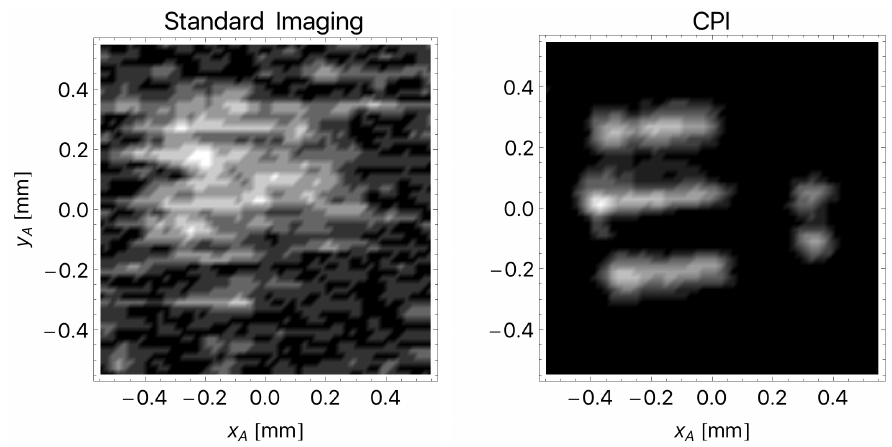
Figure 8. Experimental demonstration of CPI as obtained in the setup of Figure 10. The out of focus image of the object (element 3 of group 2 of a positive USAF-1951 test target) is reported in the left panel, while the refocused image is represented in the right panel. This experimental scenario, labelled by B in Figure 7, is characterized by z b − z a = 21mm. The experimental data are retrieved with a pixel size δ x = 7.2 µ m, coinciding with the resolution limit, as determined by diffraction; the effective pixel size of the refocused image is scaled by a factor z b / z a , in line with Equation (12). After correlation measurement, the uncorrelated background has been removed by combining a Gaussian low-pass filter with thresholding in the Fourier domain (experimental results originally published in Ref. [42]). Reproduced with the permission from [42], copyright American Physical Society, 2017.